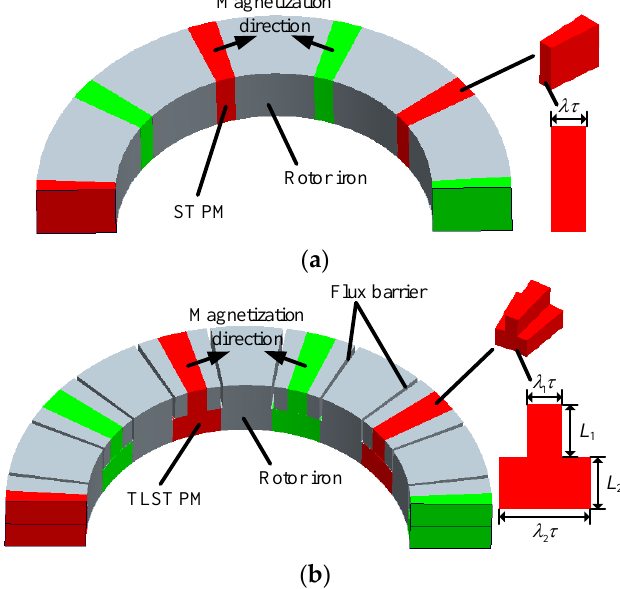
Figure 1. Structure of the rotor (half side in axial direction): ( a ) rotor with spoke-type (ST) permanent magnets; ( b ) rotor with two-layer spoke-type (TLST) permanent magnets and flux barriers.